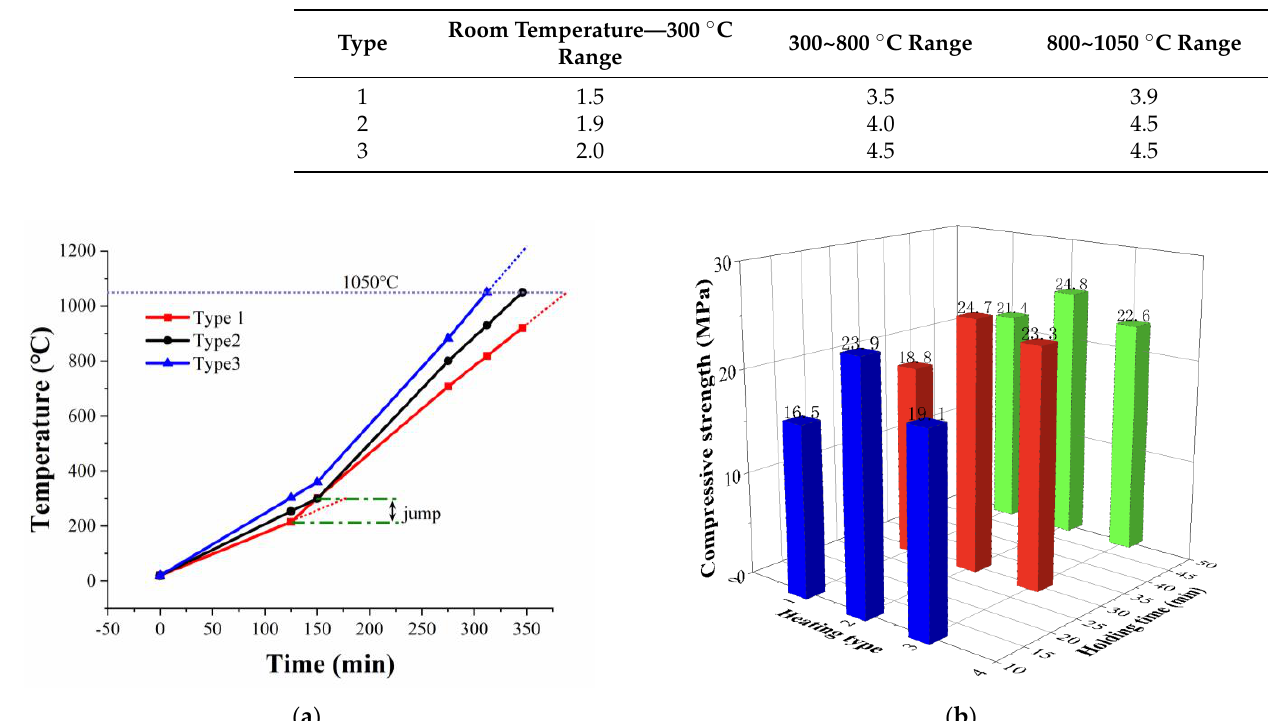
Figure 7. Effect of heating rate and holding time on compressive strength of MGS sintered brick. ( a ) Temperature variation law with time under different heating types. ( b ) Variation of compressive